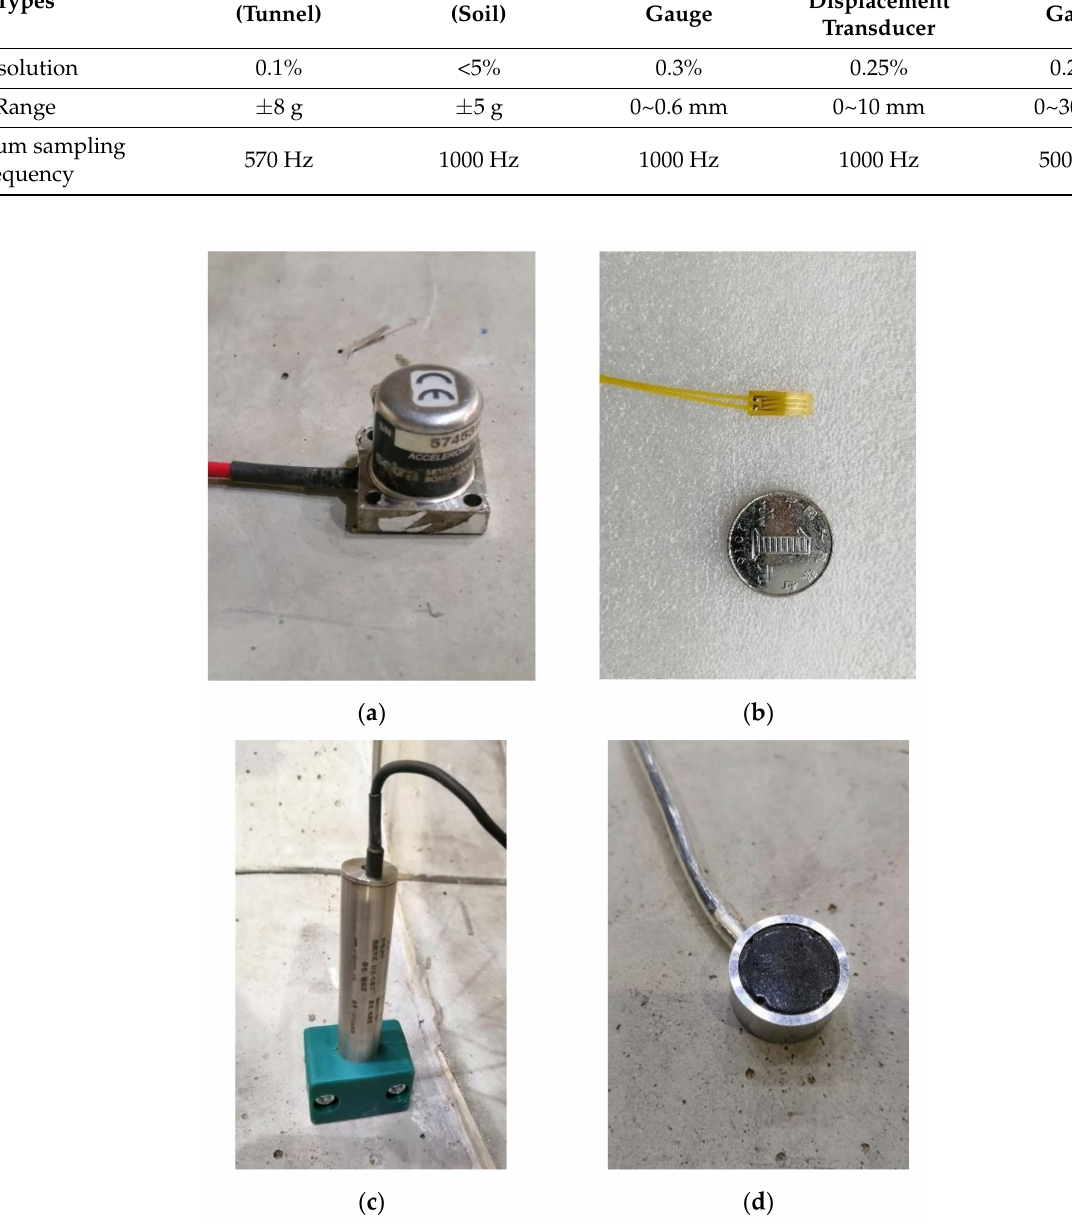
Figure 10. Arranged sensors. ( a ) Accelerometer. ( b ) Displacement gauge. ( c ) Inductive displacement transduce. ( d ) Earth pressure